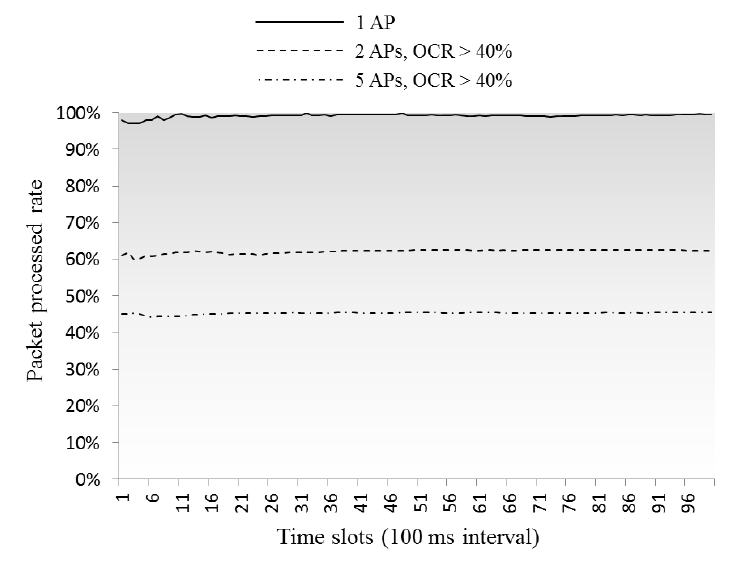
Figure 11. Rate of number of processed packets to number of arrived packets.